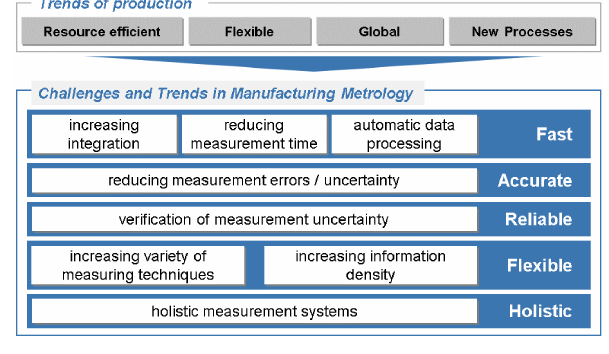
Figure 3. Requirements and trends from the VDI 2020 Manufac- turing Metrology Roadmap (updated in 2015).